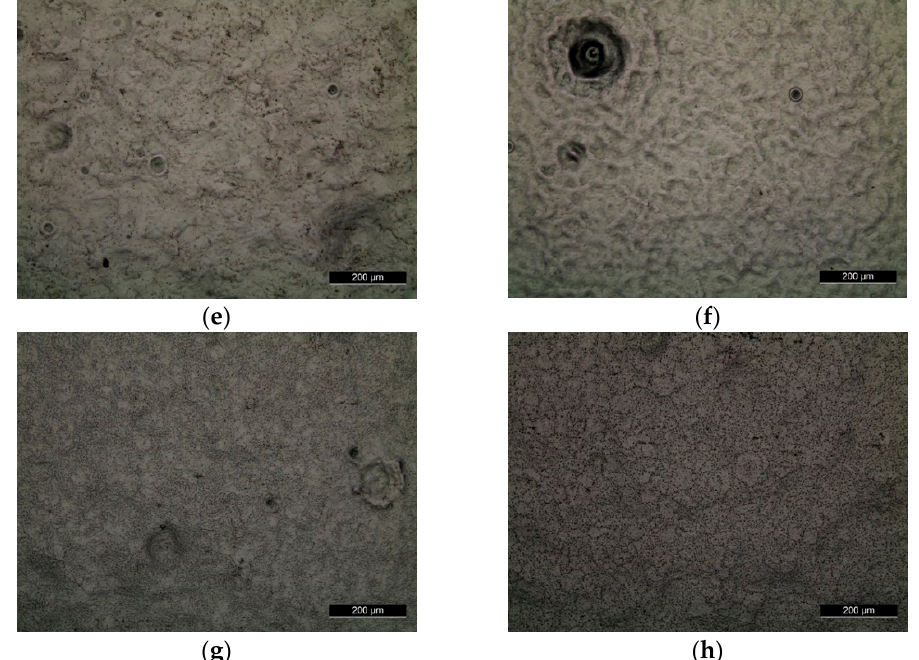
Figure 2. Optical micrographs of samples: ( a ) Ti-etched, ( b ) Ti-EB, ( c ) 1, ( d ) 2, ( e ) 5, ( f ) 6, ( g ) 11 and ( h ) 12.